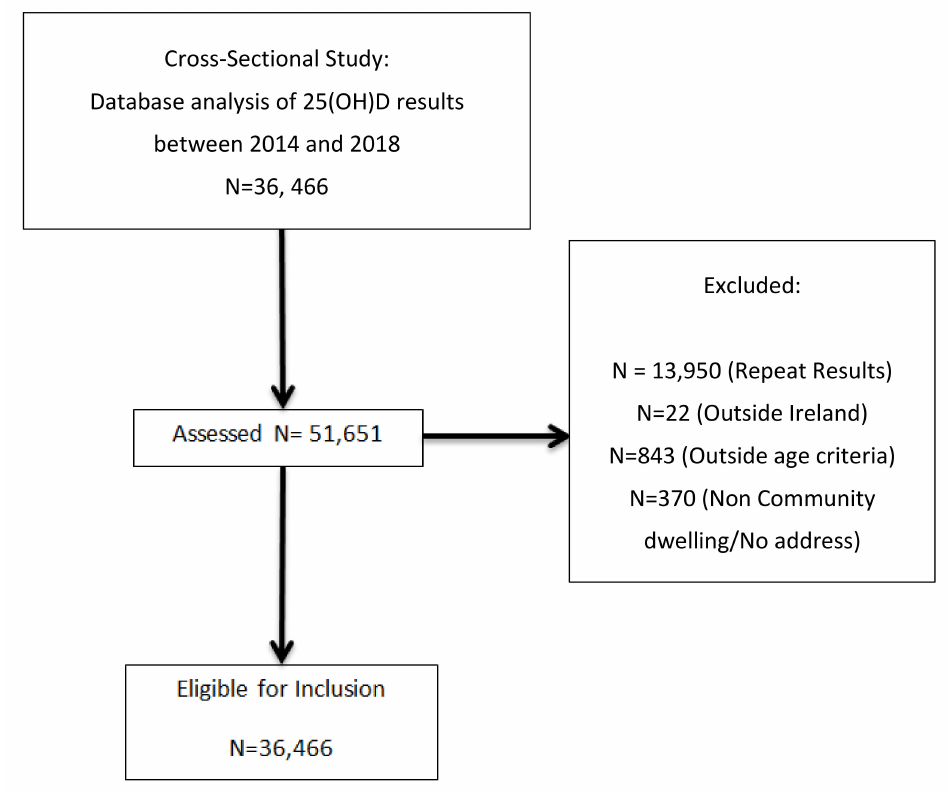
Figure 1. Recruitment Flow